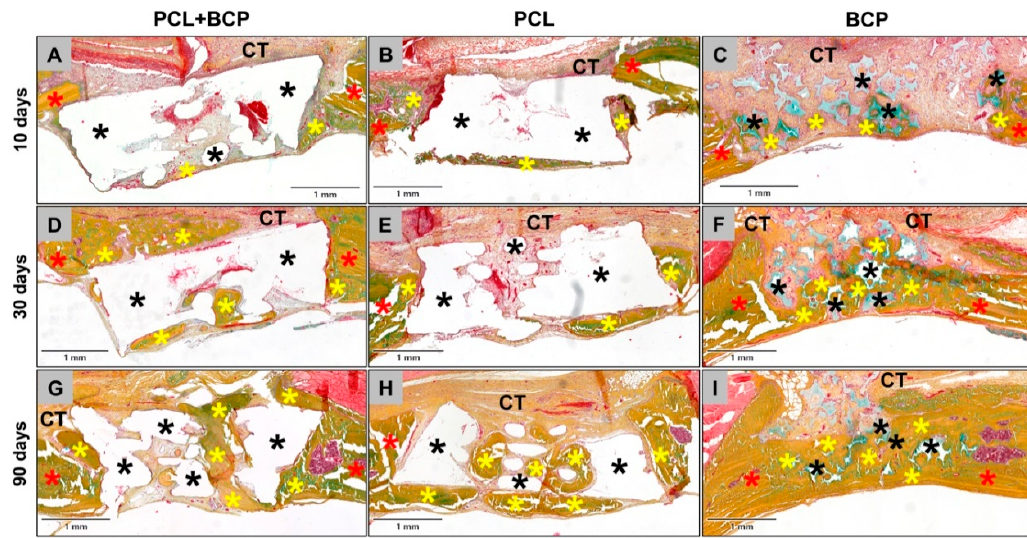
Figure 8. Exemplary total scans that show the (bone) tissue integration of the three biomaterials through the course of the study. ( A – C ) Implantations beds at day 10 post implantationem, ( D – F ) implantations beds at day 30 post implantationem and ( G – I ) implantations beds at day 90 post implantationem. Black asterisks = biomaterials, yellow asterisks = newly formed bone, red asterisks = local bone, CT = connective tissue (Movat Pentachrome stainings, 3.5× magnifications, scalebars = 1 mm).